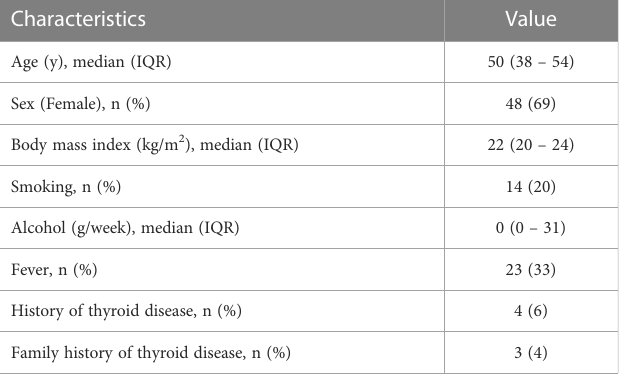
TABLE 1 Baseline cohort characteristics and time course of Anti-SARS- CoV-2 S IgG antibody, TRAb, TSH, FT4, and FT3 (n = 70).